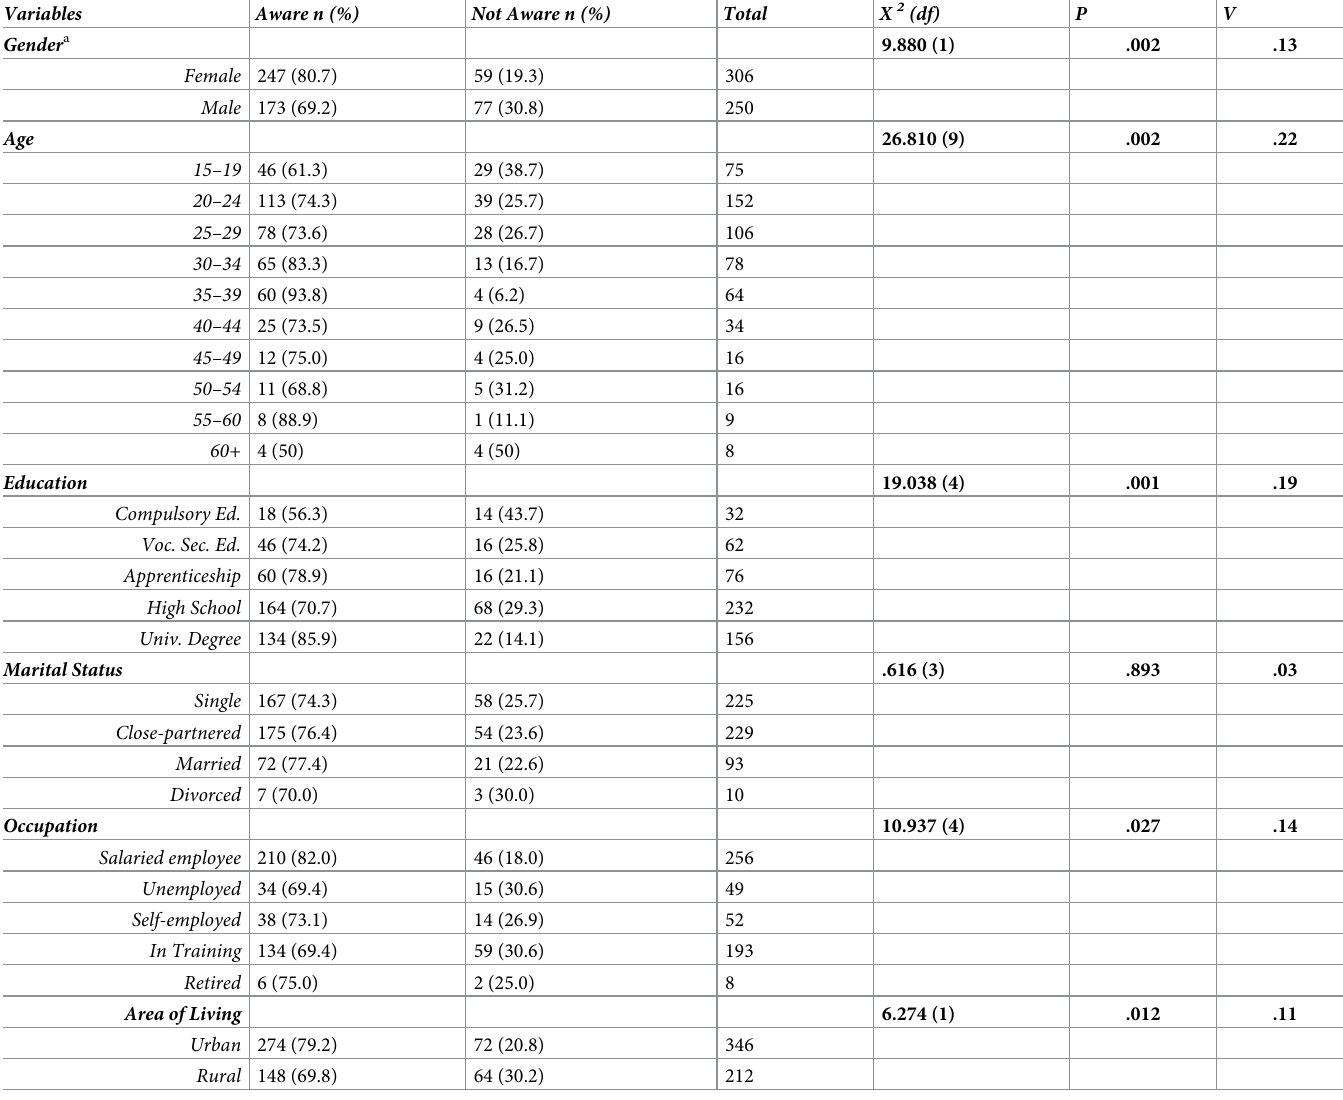
Table 2. Coherence of demographic variables and general awareness regarding